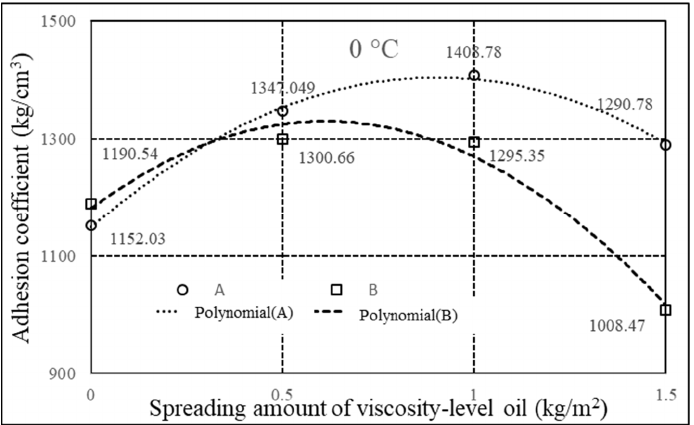
Figure 14. Adhesion coefficient curve of viscosity-level oil A and B specimens at 0 °C.